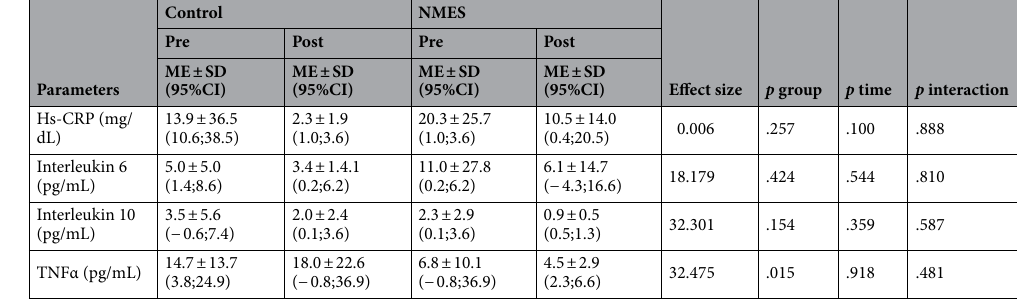
Table 1. Biochemical analyses. ANOVA two-way (group × time interaction). ME Mean, SD Standard deviation, Hs-CRP High sensitive C reactive protein, TNFα Tumor necrosis factor alpha, NMES Neuromuscular electrical